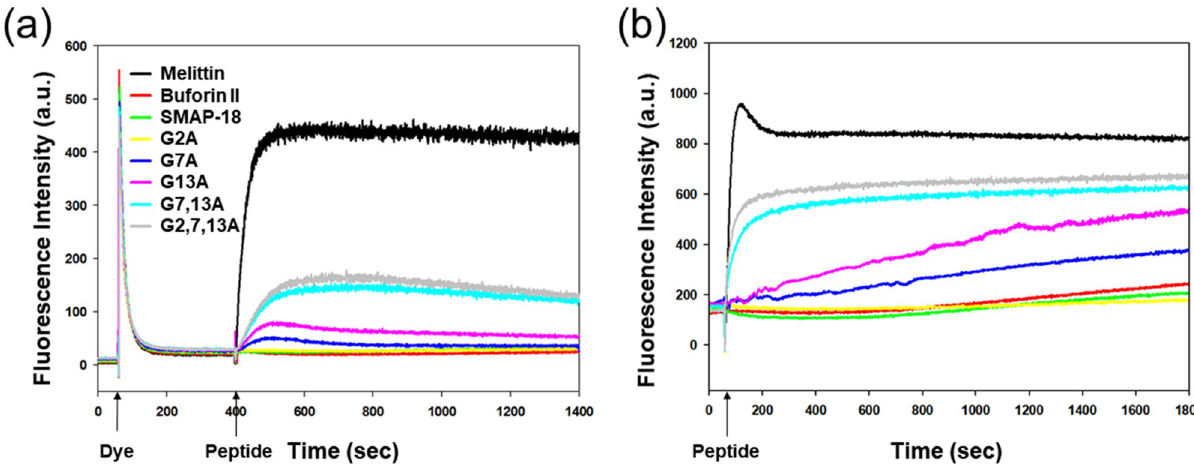
Figure 6. Mechanism assay of SMAP-18 peptides. ( a ) Time-dependent membrane depolarization of S. aureus at 2 × MIC. ( b ) SYTOX Green uptake assay induced by the SMAP-18 peptides at 2 ×